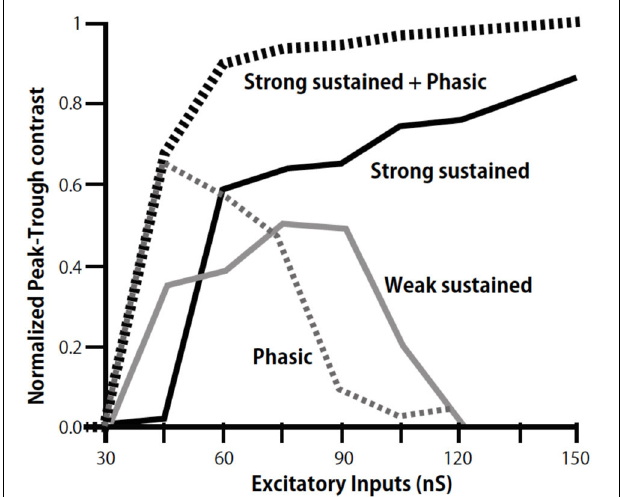
FIGURE 4 | Modulation of peak-trough contrast of ITD tuning curve of low-CF NL neurons by inhibition. Peak-trough contrasts of ITD tuning curve are calculated by including the sustained inhibition of weak (gray line), strong (black line), and phasic inhibition (dotted gray line) separately, and by including both the strong sustained and the phasic inhibition (dotted black line). Modified from Yamada et al.